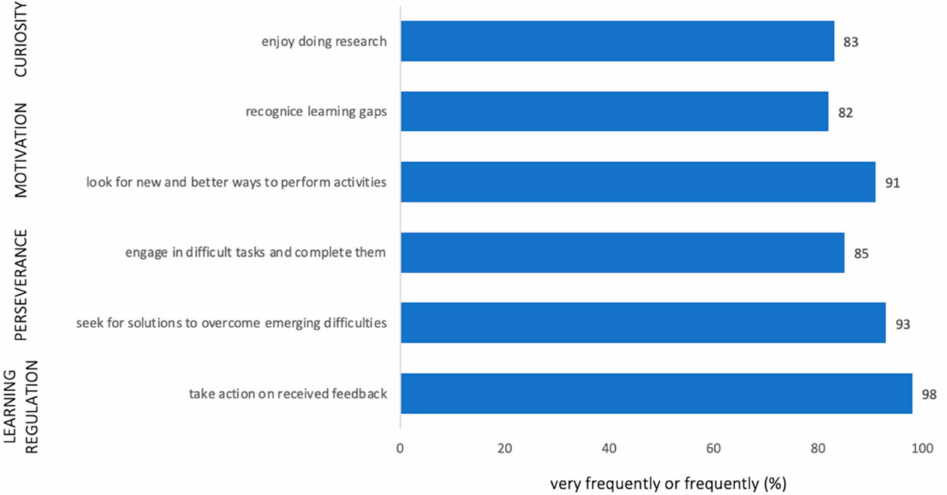
Figure 2. Opportunities to promote lifelong learning tendencies recognized by pre-service